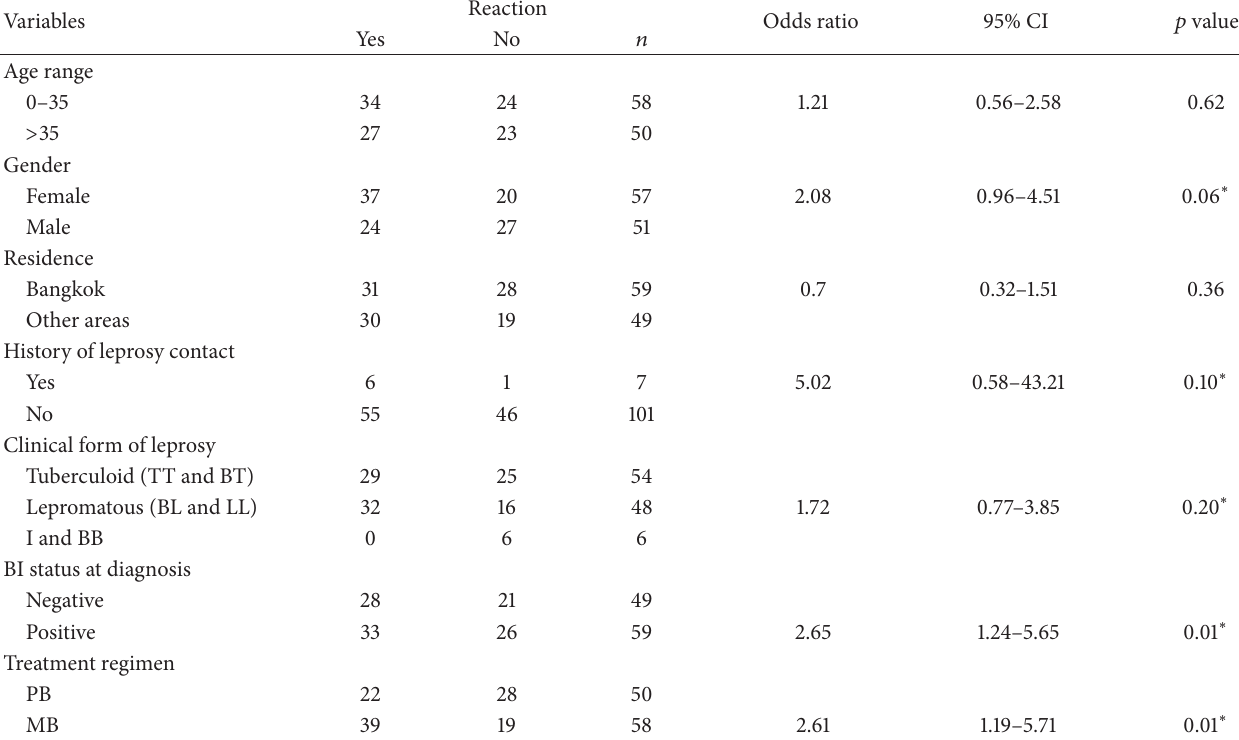
Table 3: Univariate analysis.